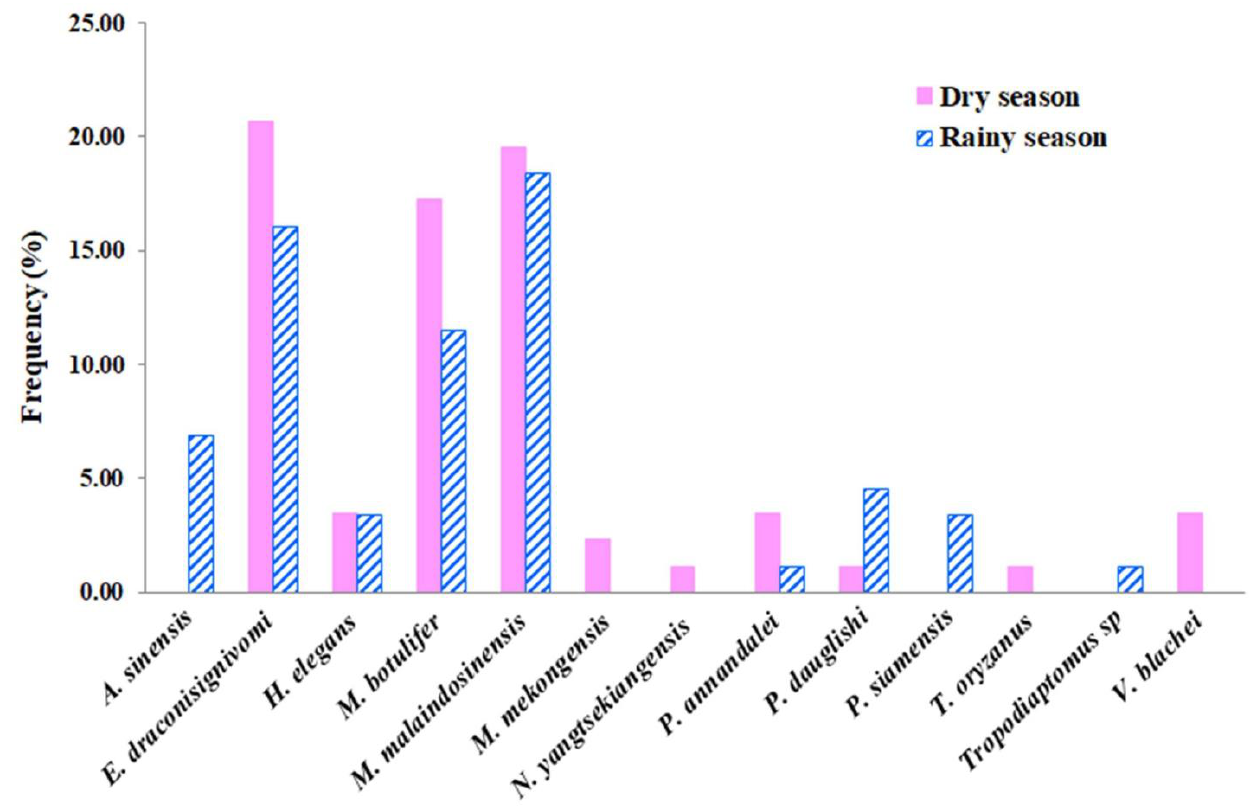
Figure 4. The frequency percentages of calanoid species found in southern Vietnam during the dry and rainy and rainy seasons.